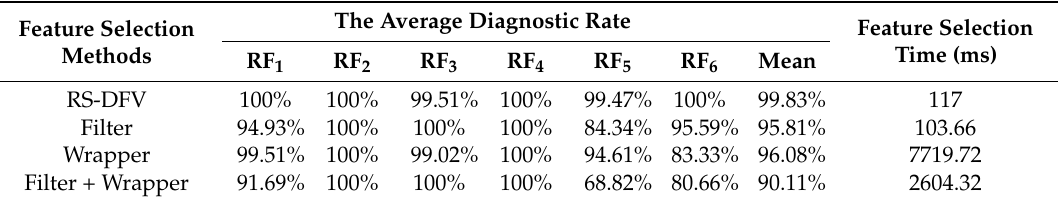
Table 12. Comparison with other feature selection methods.